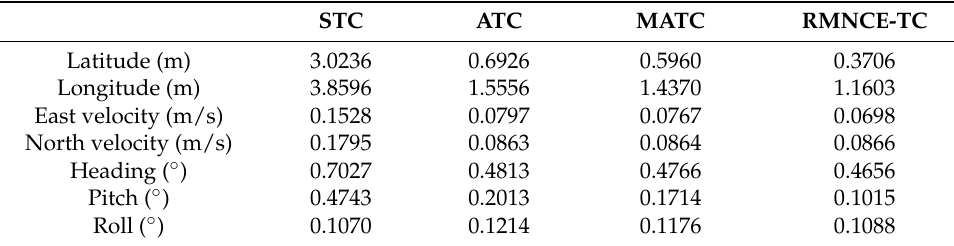
Table 3. RMSE obtained by the different schemes.